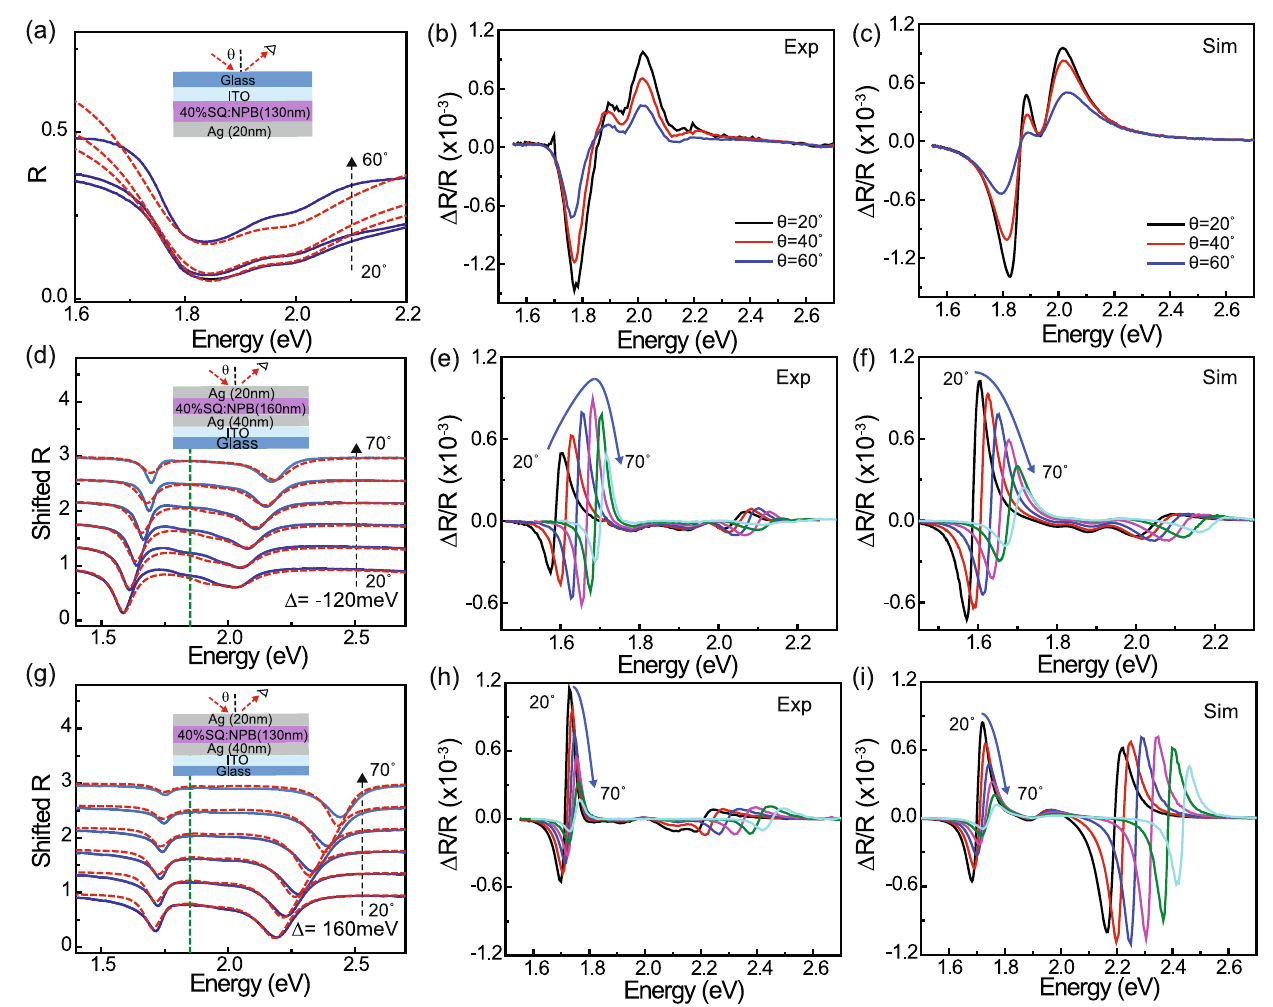
Fig.3|Microcavityelectrore fl ectanceathighSQconcentration. Re fl ectivityand EA data for devices with a 40wt% SQ:NPB active layer. a Angle-dependent s- polarized re fl ectivity spectra measured for a half-cavity control device (blue solid lines) together with corresponding transfer matrix simulations (red dashed lines) based on the associated optical constant dispersion in Fig. 1. Panels b and c show the measured and simulated electrore fl ectance spectra for this device; the simu- lation is produced by red-shifting and strengthening the Lorentz oscillators that modeltheSQdispersionasdescribedinthemaintext. d – f and g – i showanalogous